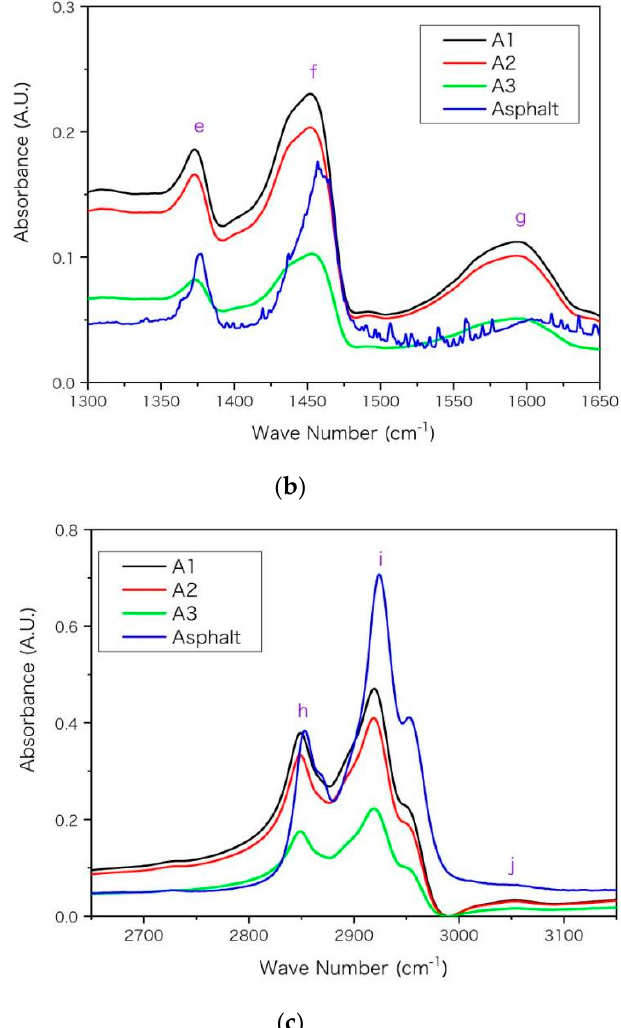
Figure 3. The FTIR spectra for the asphaltenes (A1, A2 and A3) and asphalt with wave number (in unit of cm − 1 ) in ranges of ( a ) 600–1100, ( b ) 1300–1650, ( c ) 2650–3150, respectively. The absorbance is in arbitrary unit (A.U.) and main peaks are marked in alphabetical order. Table 6. The wave number (in unit of cm − 1 ) for main peaks on IR spectra for the extracted asphal- tenes (A1, A2 and A3) and the base asphalt 1 .